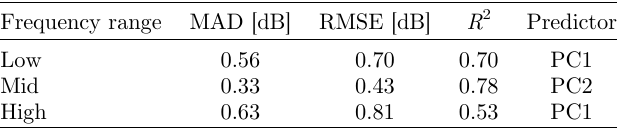
Table 2. Performance parameters for the linear model based on texture PCA data: mean absolute deviation (MAD), root mean squared error (RMSE) and coef fi cient of determination ( R 2 ) for the three frequency